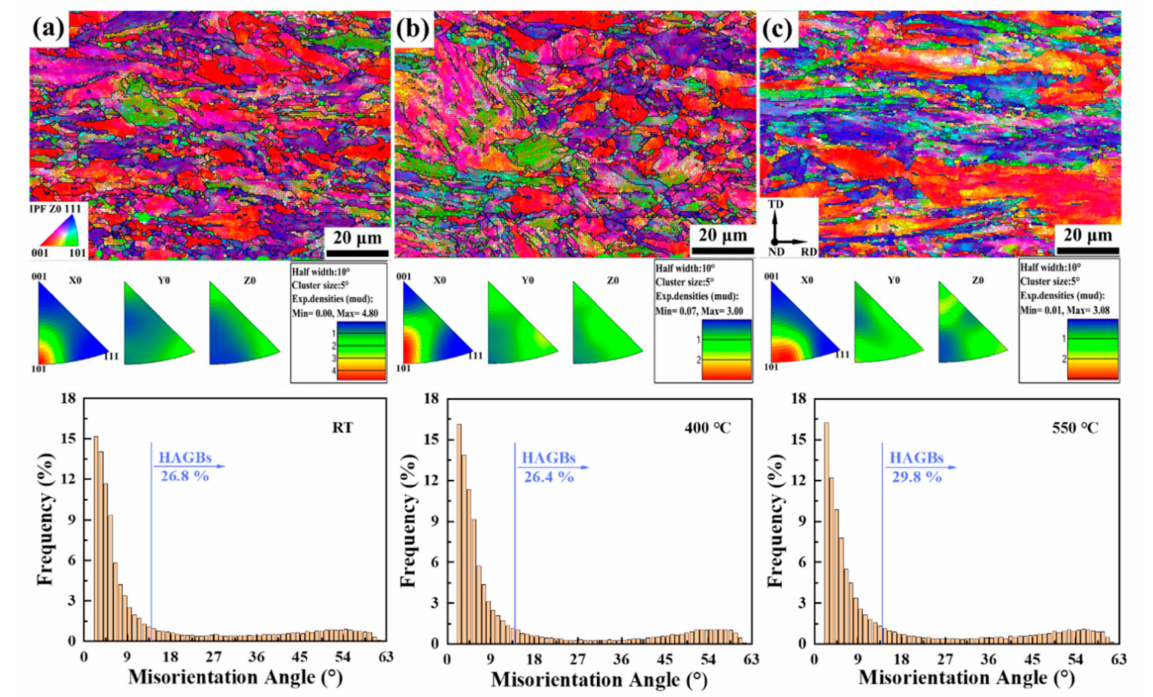
Figure 6. IPFs maps of plane A at ( a ) RT, ( b ) 400 ◦ C, and ( c ) 550 ◦ C of 9Cr-F/M steel and the histogram of misorientation angle of Z0 direction corresponding to each